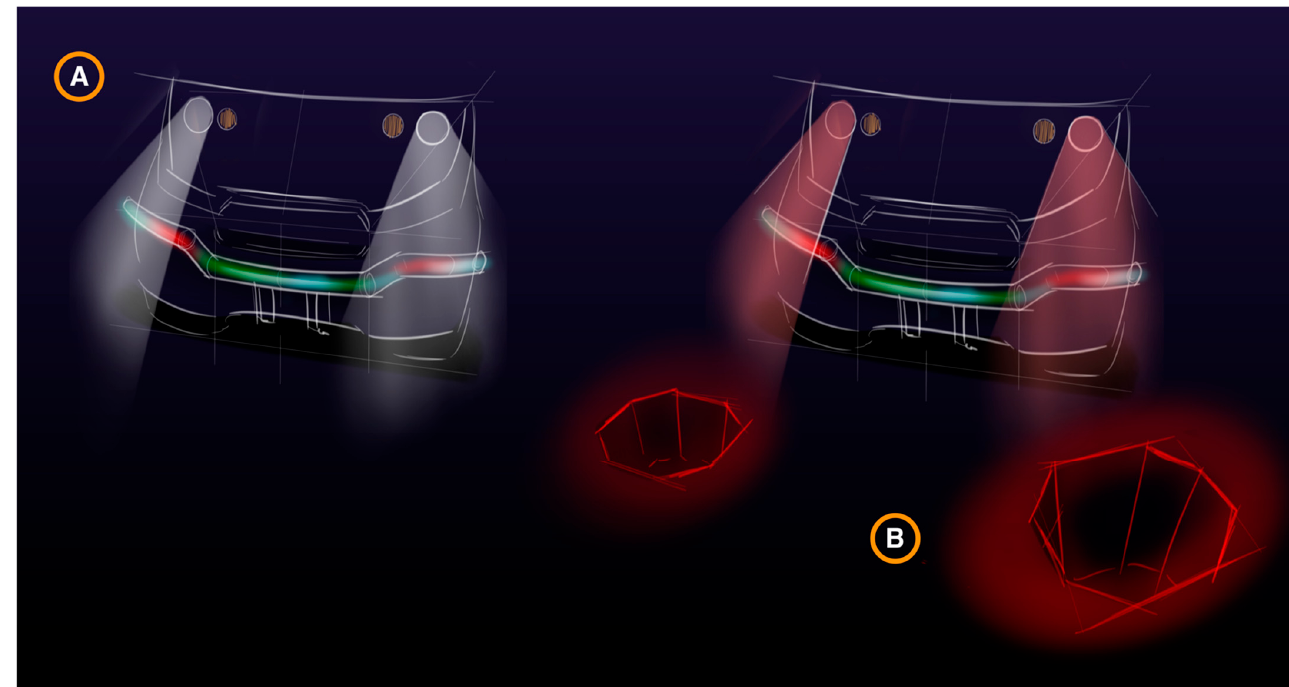
Figure 1. AV Projection Concepts by Brian Mason for MDAS.ai, an autonomous shuttle being de- veloped from the ground-up for use within University of Michigan–Dearborn. ( A ) Shows the stand- ard OEM headlights and lightbar indicator; ( B ) shows the projected warning. In this design, they are meant to simulate a hole in the shape of stop signs.